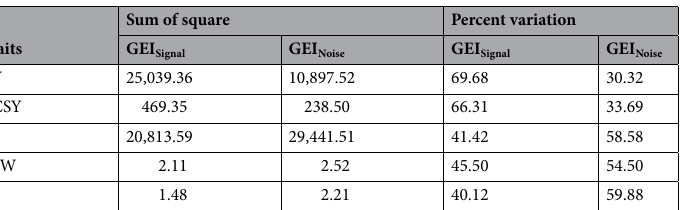
Table 6. Estimates of sum of square due to signals and noises by using AMMI model for drought stress in sugarcane. GEI genotype × environment interaction, CY cane yield (t/ha), CCSY commercial cane sugar yield (t/ha), SL stalk length (cm), ST stalk thickness (cm), SCW single cane weight (kg), NMC number of millable